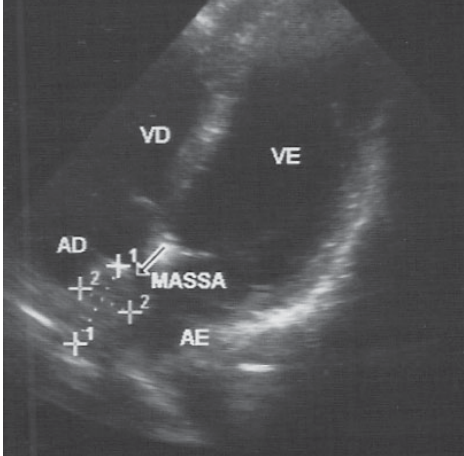
Fig. 1 - Ecocardiograma pré-operatório com visualização de massa em átrio direito